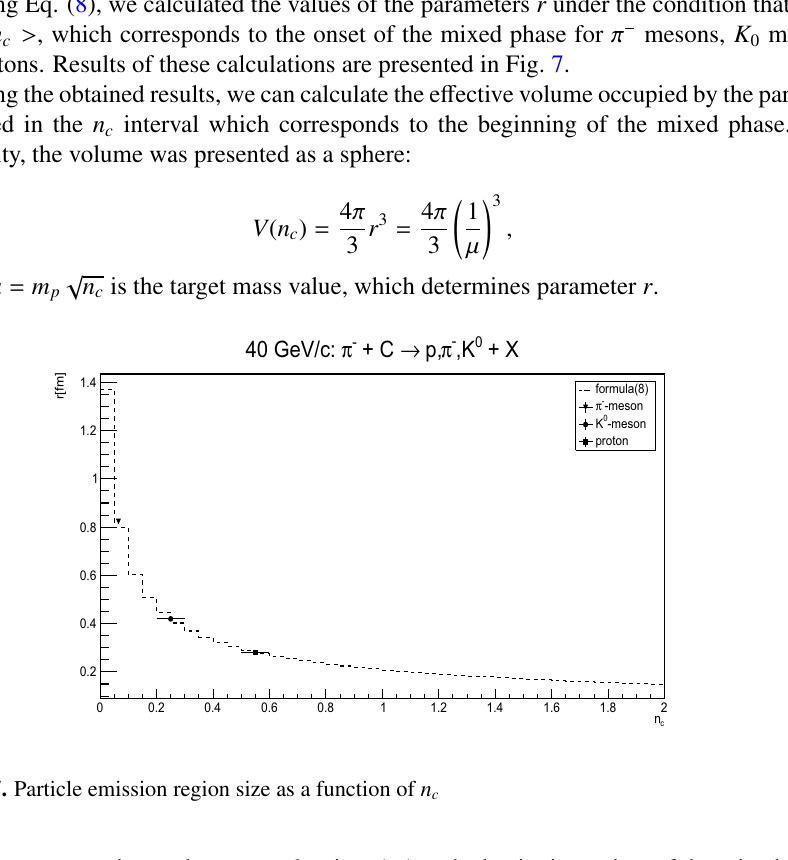
π − C interactions at